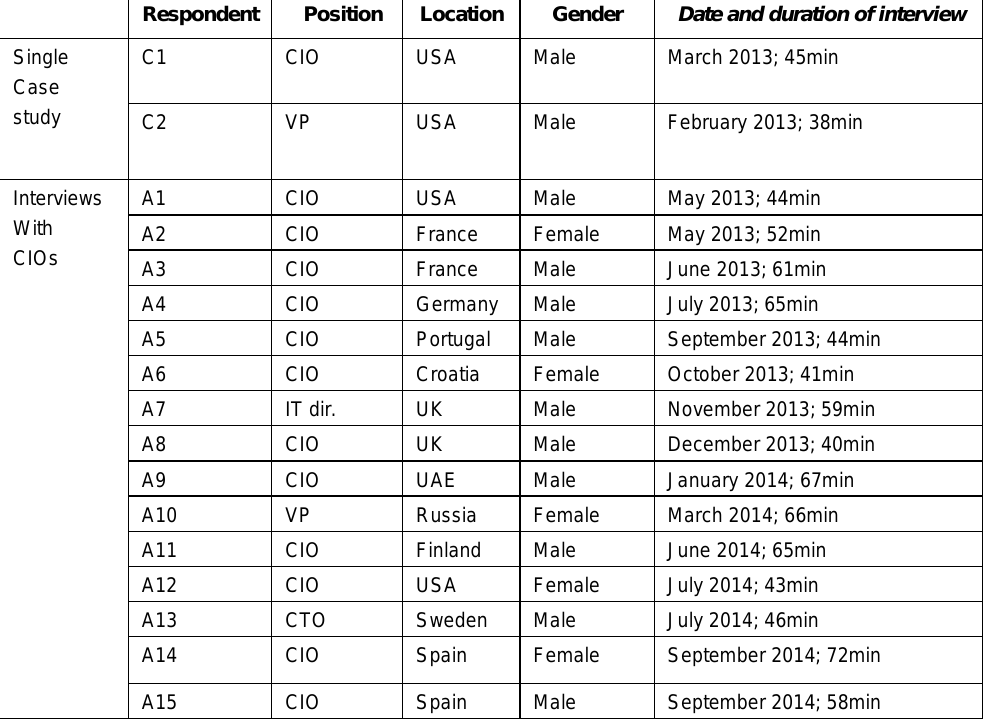
Table 1. Summary of participant